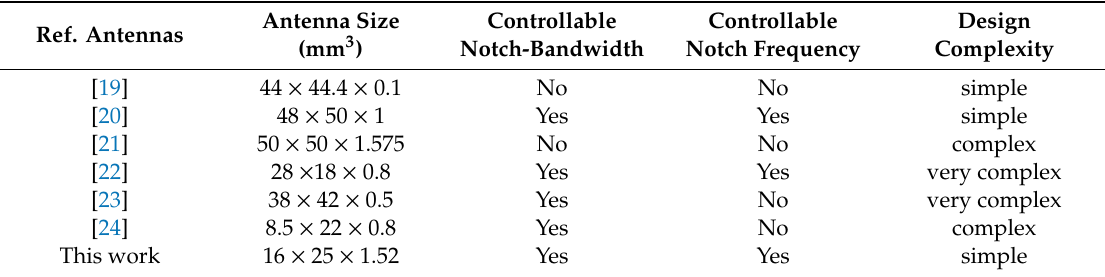
Table 1. Performance comparison of the proposed antenna with existing rectangular notched antenna in